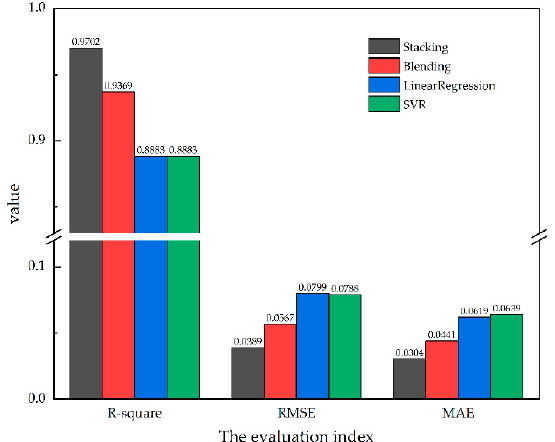
Figure 12. Comparison of prediction performance of stacking ensemble learning model, blending ensemble learning model, linear regression model, and SVR model.